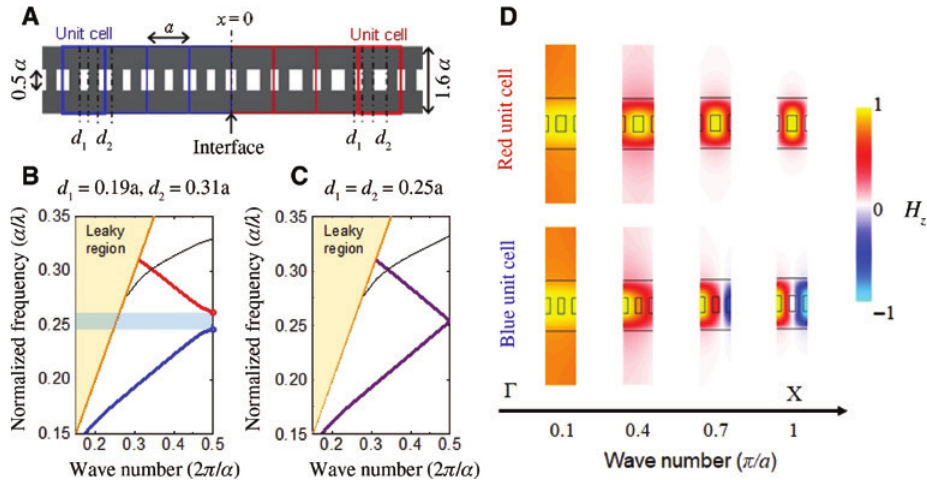
Figure 4: 1D topological photonic crystal nanobeam. (A) Details of the design of the topological nanocavity based on photonic crystal nanobeams, the schematic of which is depicted in Figure 1E. The interface is formed between a topological photonic crystal based on the blue unit cell and a trivial photonic crystal with the red unit cell. (B) Computed optical bands for the photonic crystal constituted of the blue unit cell with d = d = 0.25 a . (D) Evolution of wavefunctions across the momentum space, calculated for the trivial and topological photonic crystals. (A–C) d 1 2 Reproduced from Ref.